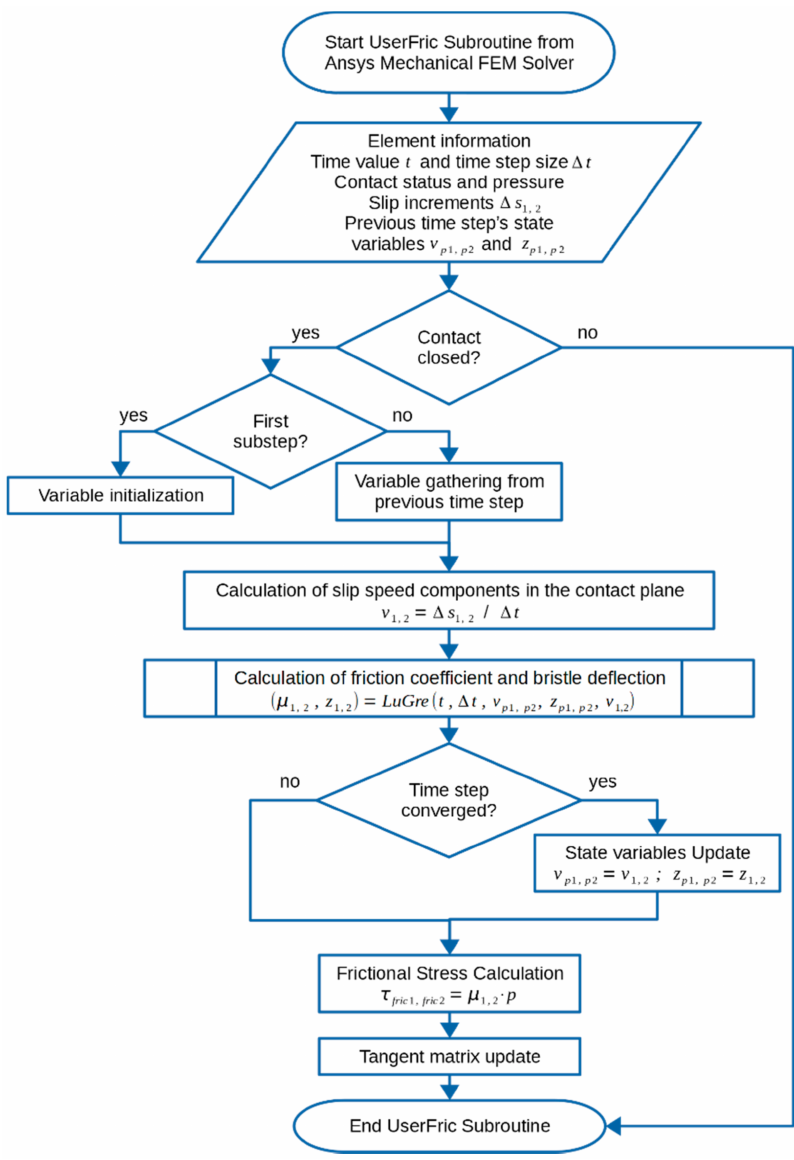
Figure 6. Program flow chart of the userfric